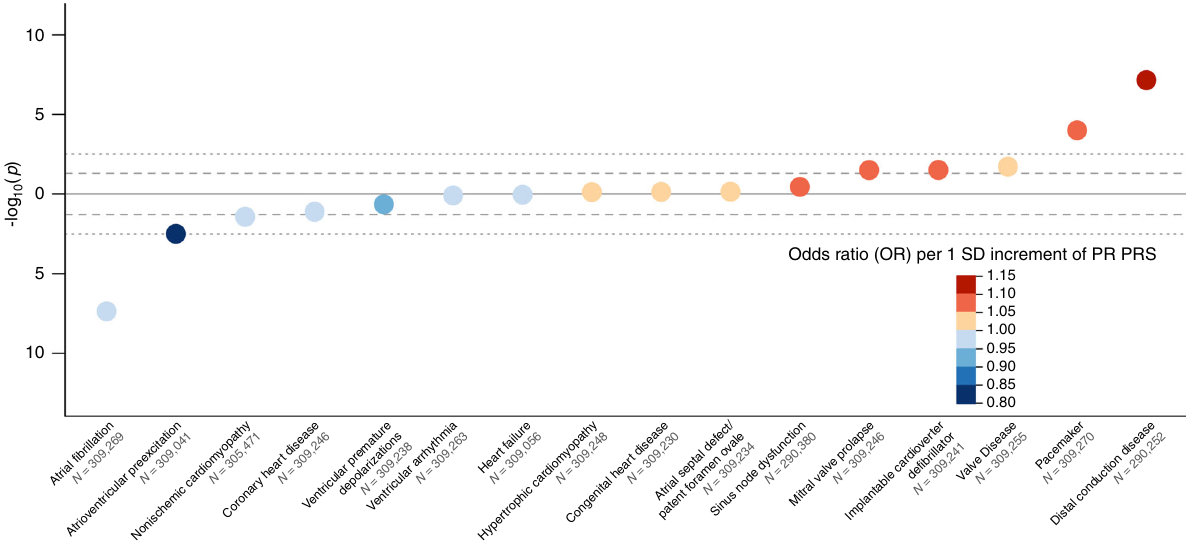
Fig. 4 Bubble plot of phenome-wide association analysis of European ancestry PR interval polygenic risk score. The polygenic risk score was derived from the European ancestry meta-analysis. Orange circles indicate that polygenic predisposition to longer PR interval is associated with an increased risk of the condition, whereas blue circles indicate that polygenic predisposition to longer PR interval is associated with lower risk of the condition. The darkness of the color re fl ects the effect size (odds ratio, OR) per 1 standard deviation (s.d.) increment of the polygenic risk score from logistic regression. Sample size ( N ) in each regression model is provided under X -axis. Given correlation between traits, we set signi fi cance threshold at P < 3.13 × 10 − 3 after Bonferroni correction ( P < 0.05/16; dotted line) for the analysis and also report nominal associations ( P < 0.05; dashed line).